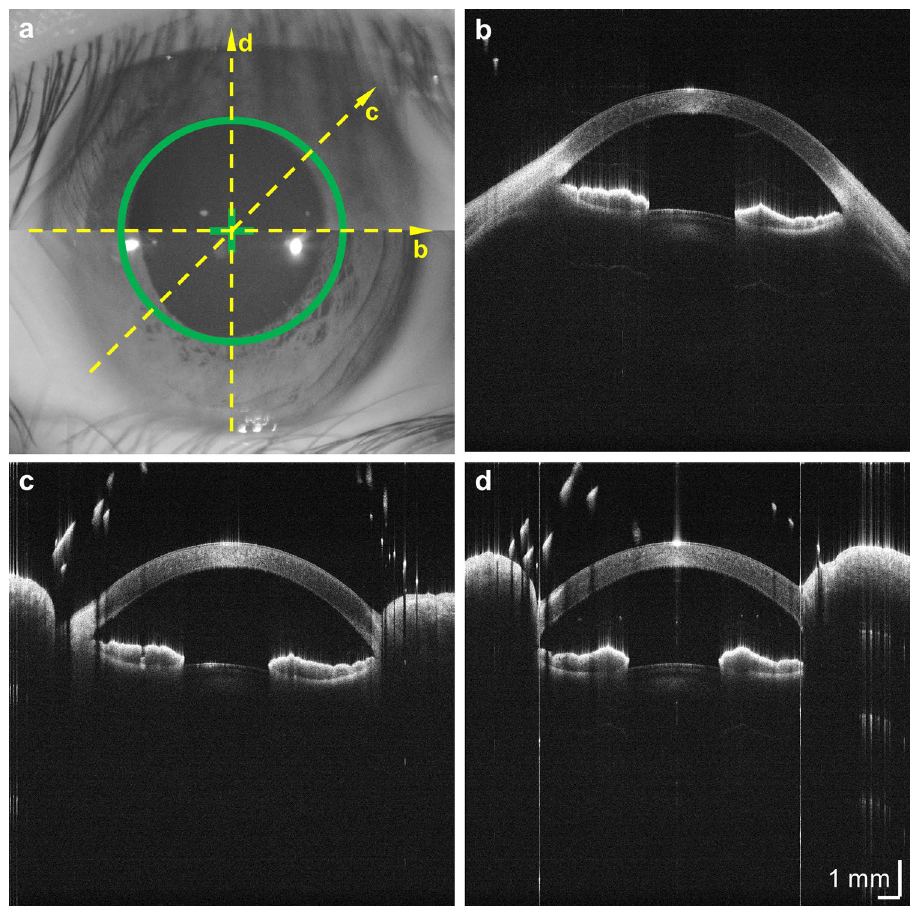
Figure 2. Split view iris camera view and radial corneal-scleral scans. ( a ) Composite “split view” iris image after optimum instrument alignment. Iterative adjustments in the transverse and axial direction center the image and align the top and bottom halves, placing the iris in the center of the OCT scan field and at correct axial working distance. ( b )–( d ) 20-mm OCT B-scans from 3 meridians indicated in ( a ), respectively. Accurate alignment is especially important for biometry